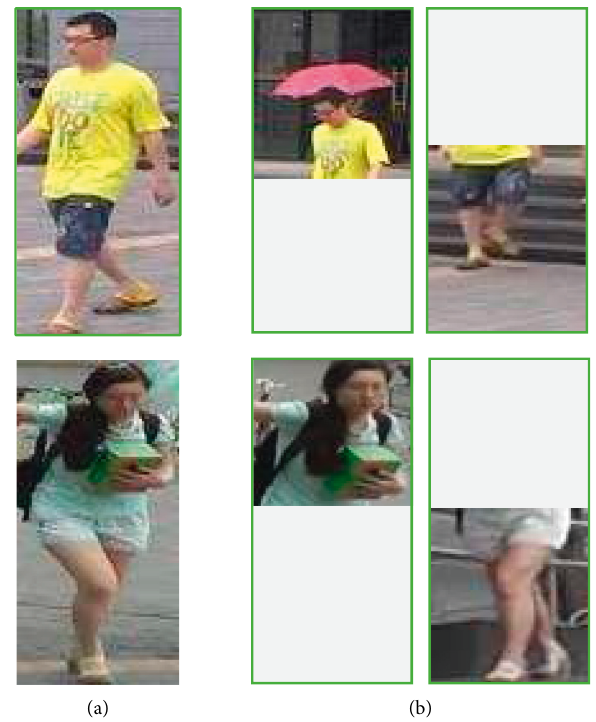
Figure 4: Results of the proposed algorithm on the Market1501 dataset. (a) The whole image. (b) The local image.